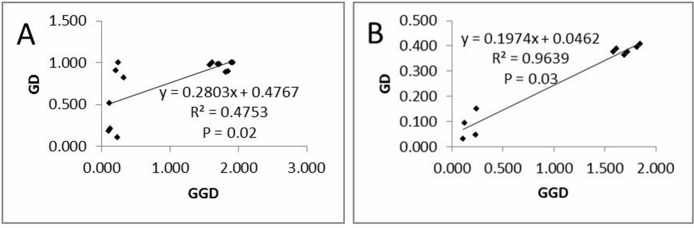
Scatterplots showing the relationship between genetic distance (GD) and geographic distance (GGD) based on cpDNA (A) and SSR data (B).